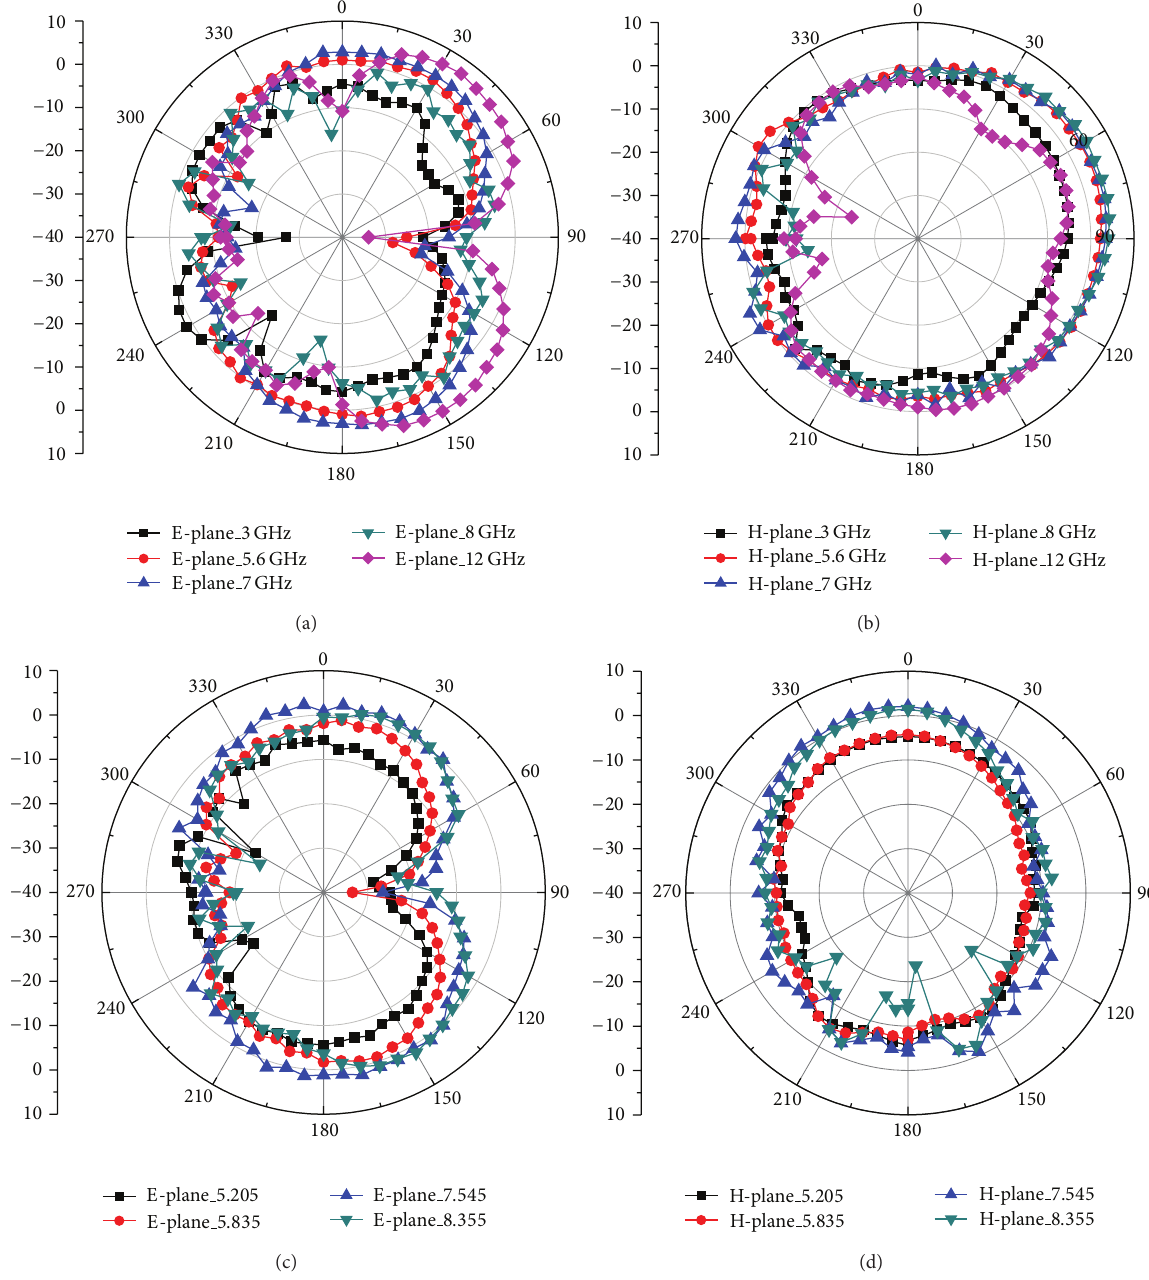
Figure 6: Radiation patterns of the quadruple band-notched UWB